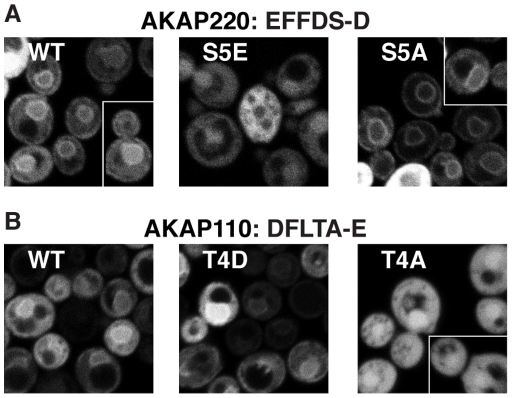
FFAT-like motifs in two AKAPs.(A) 29 amino acids from AKAP220 including the FFAT-like motif 1EFFDS-D7 (see Table 1) were expressed as in Figure 1A, together with variants at position 5: 1EFFDE-D7 and 1EFFDA-D7. The wild-type (WT) sequence showed moderate targeting, which was lost with E5 and enhanced by A5. (B) 32 amino acids from AKAP110 including the FFAT-like motif 1DFLTA-E7 (see Table 1) were expressed as (A), together with variants at position 4: 1 DFLDA-E 7 and 1 DFLAA-E 7. The wild-type (WT) sequence showed weak targeting, which was enhanced by D4 and lost with A4.